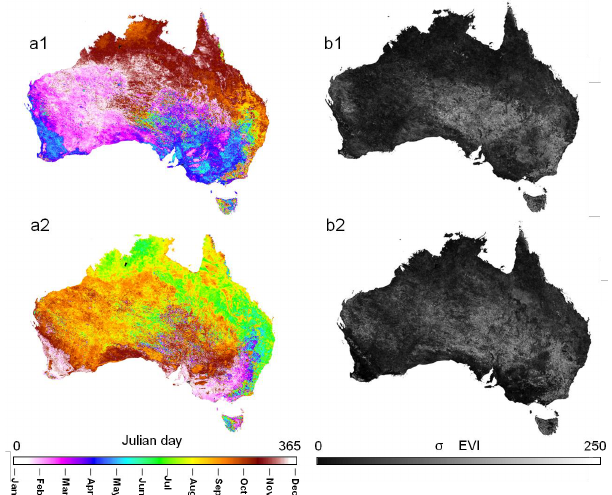
Fig 5 Figure 5. Mean Julian day of the start of the phenological cycles (a1) , standard deviation of the start of the phenological cycles in number of days (b1) , mean Julian day of the end of the phenological cycles (a2) and standard deviation of the end of the phenological cycles in number of days (b2) across the 14-year time